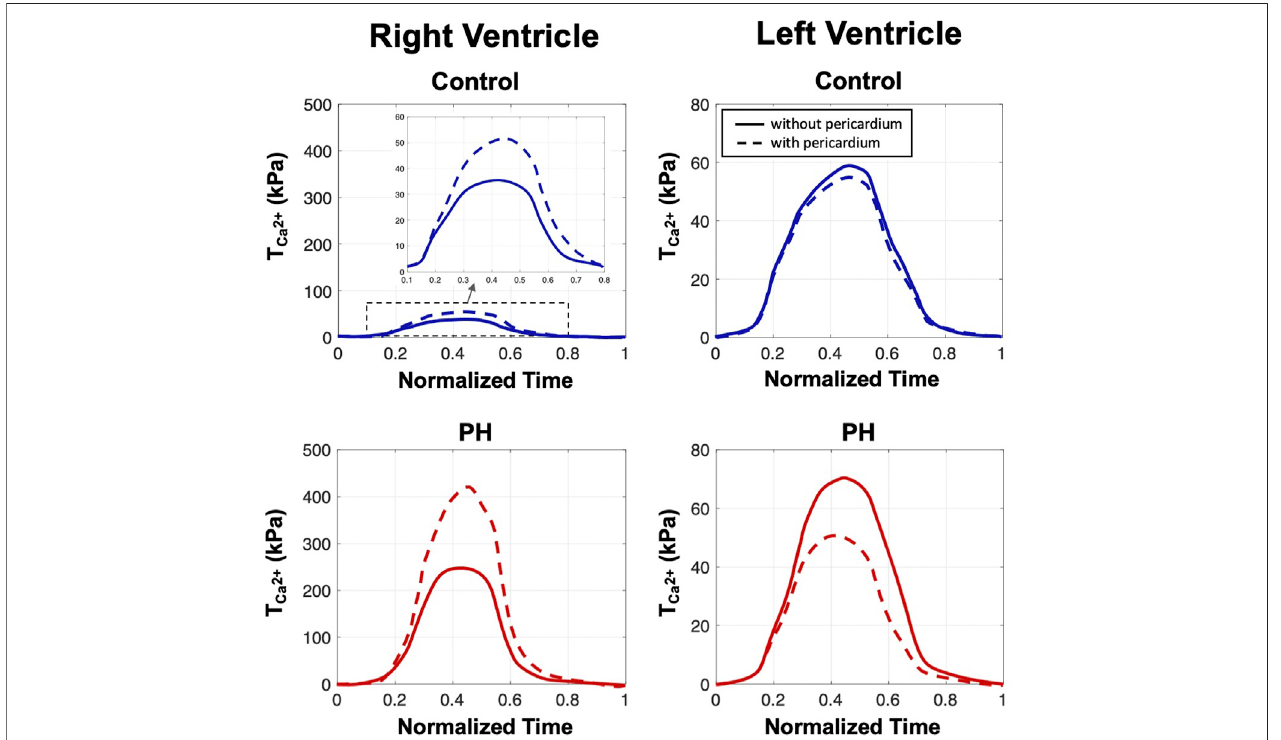
FIGURE 3 | The estimated values of the active parameter T Ca 2 + as a function of time for the control and PH hearts with and without pericardium. Curves estimated from the heart model with and without pericardium are denoted by w/P and wo/P, respectively.